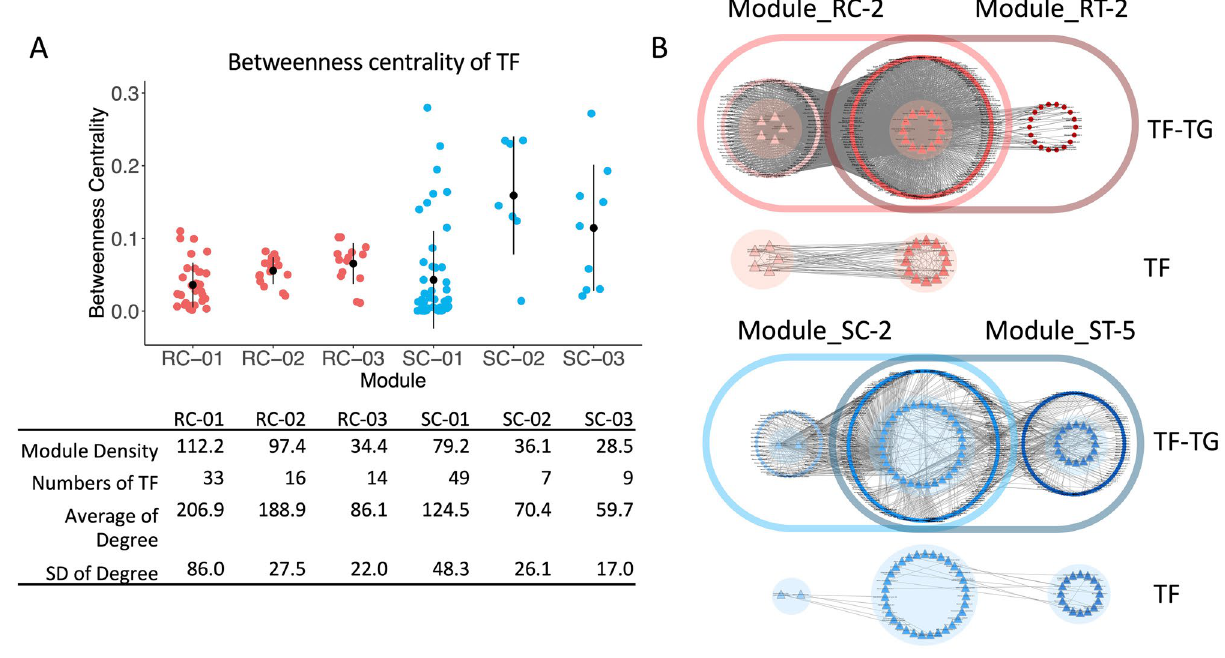
Figure 4. Betweenness centrality of TFs in TRN modules. ( A ) Jitter plot demonstrating the betweenness centrality of transcription factors (TFs) in the TRN modules. The standard deviation (SD) of the betweenness centrality of TFs in the resistant TRN was lower than for the susceptible TRN under control conditions. This suggests that other TFs in the resistant modules can alternatively be used for regulating target genes (TG) when the preferred TFs are perturbed, while the susceptible modules require specific TFs for regulating the TGs. ( B ) Venn diagram demonstrating TRN modules for each trait under control and infection conditions. Triangular nodes represent TFs, and circular nodes represent TGs. Only TF-TF associations are shown below the Venn diagram. Alternative TFs can be used during system perturbation to regulate genes via the complex topology